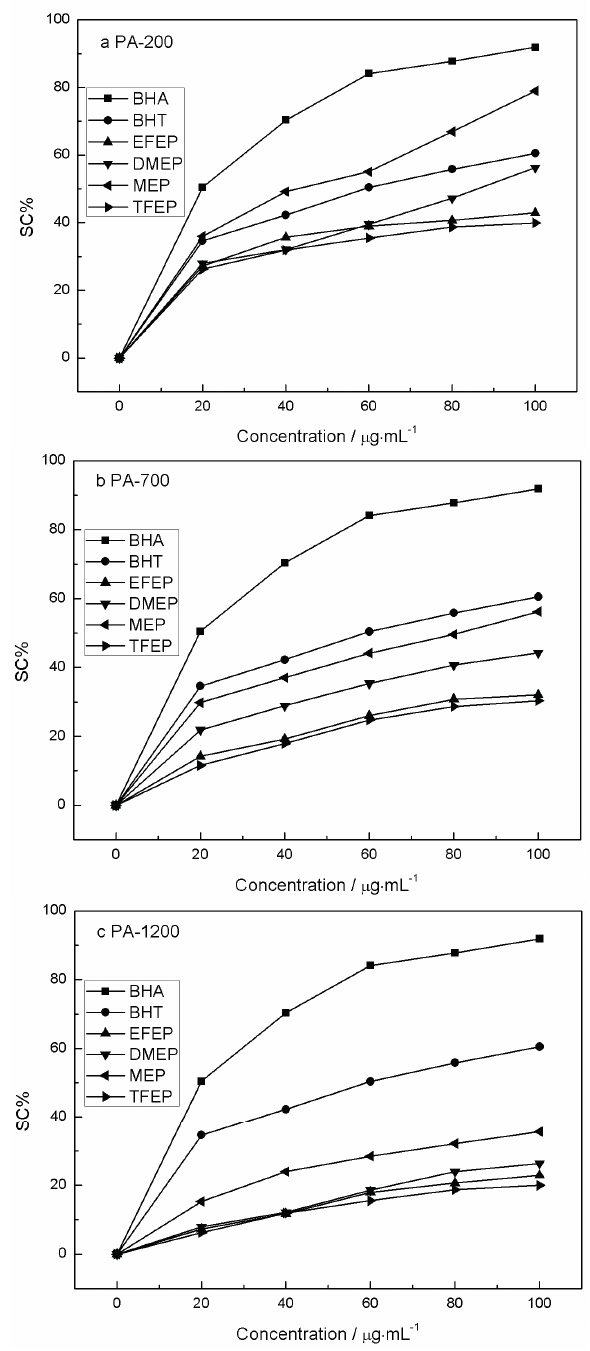
Figure 4. DPPH scavenging activities of PA extracts after ( a ) pyrolysis at 200